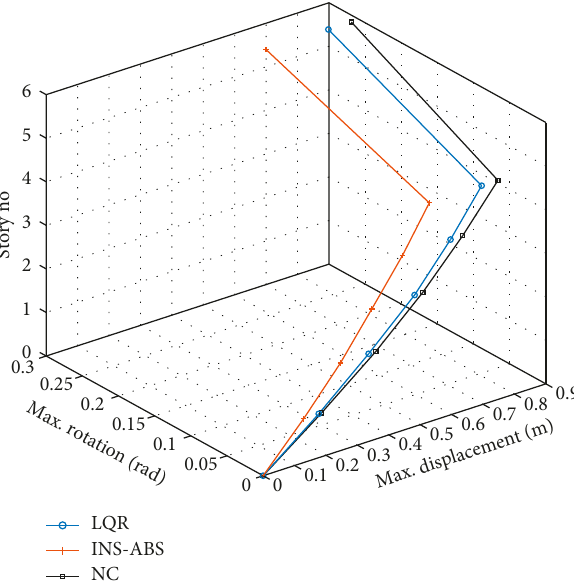
Figure 10: Maximum displacements and rotations for Northridge bidirectional ground